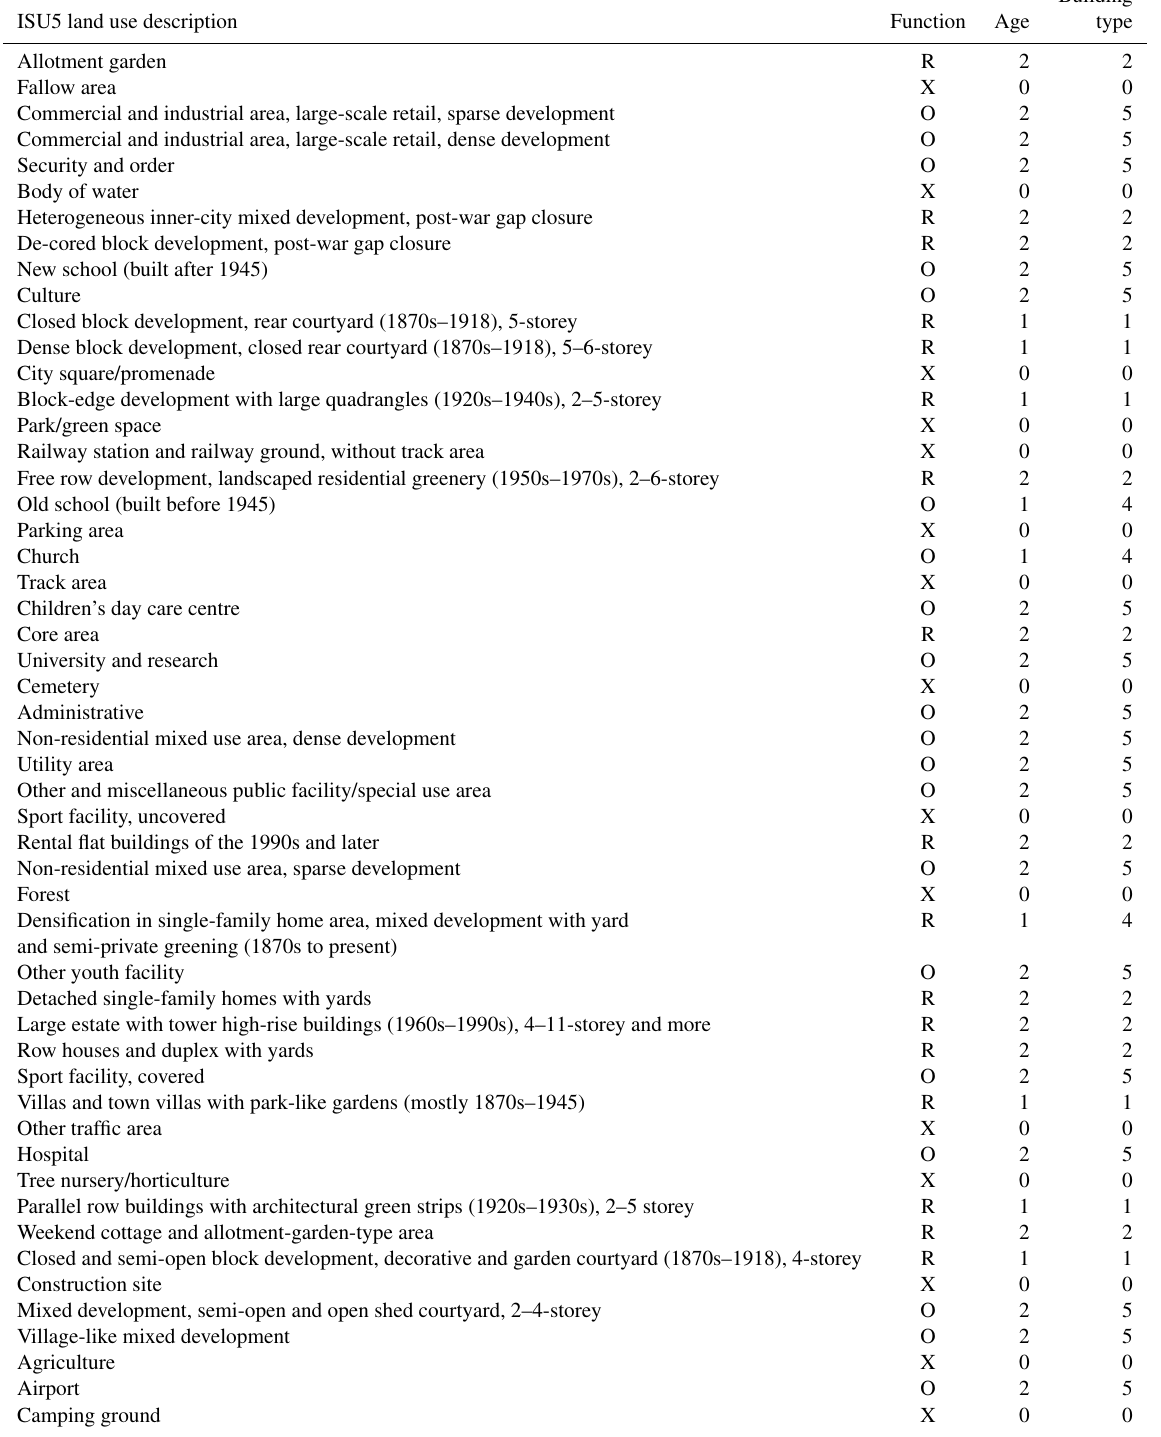
Table B7. Berlin ISU5 (Informationssystem Stadt und Umwelt, English: Information System City and Surroundings) land use descriptions to PALM building type. The building function can be R = residential, O = other, X = no building. The age classes refer to the building period before 1951 (1), between 1951 and 2000 (2), and after 2000 (3). The combination of the function and the building age according to Table A2 results in the PALM building